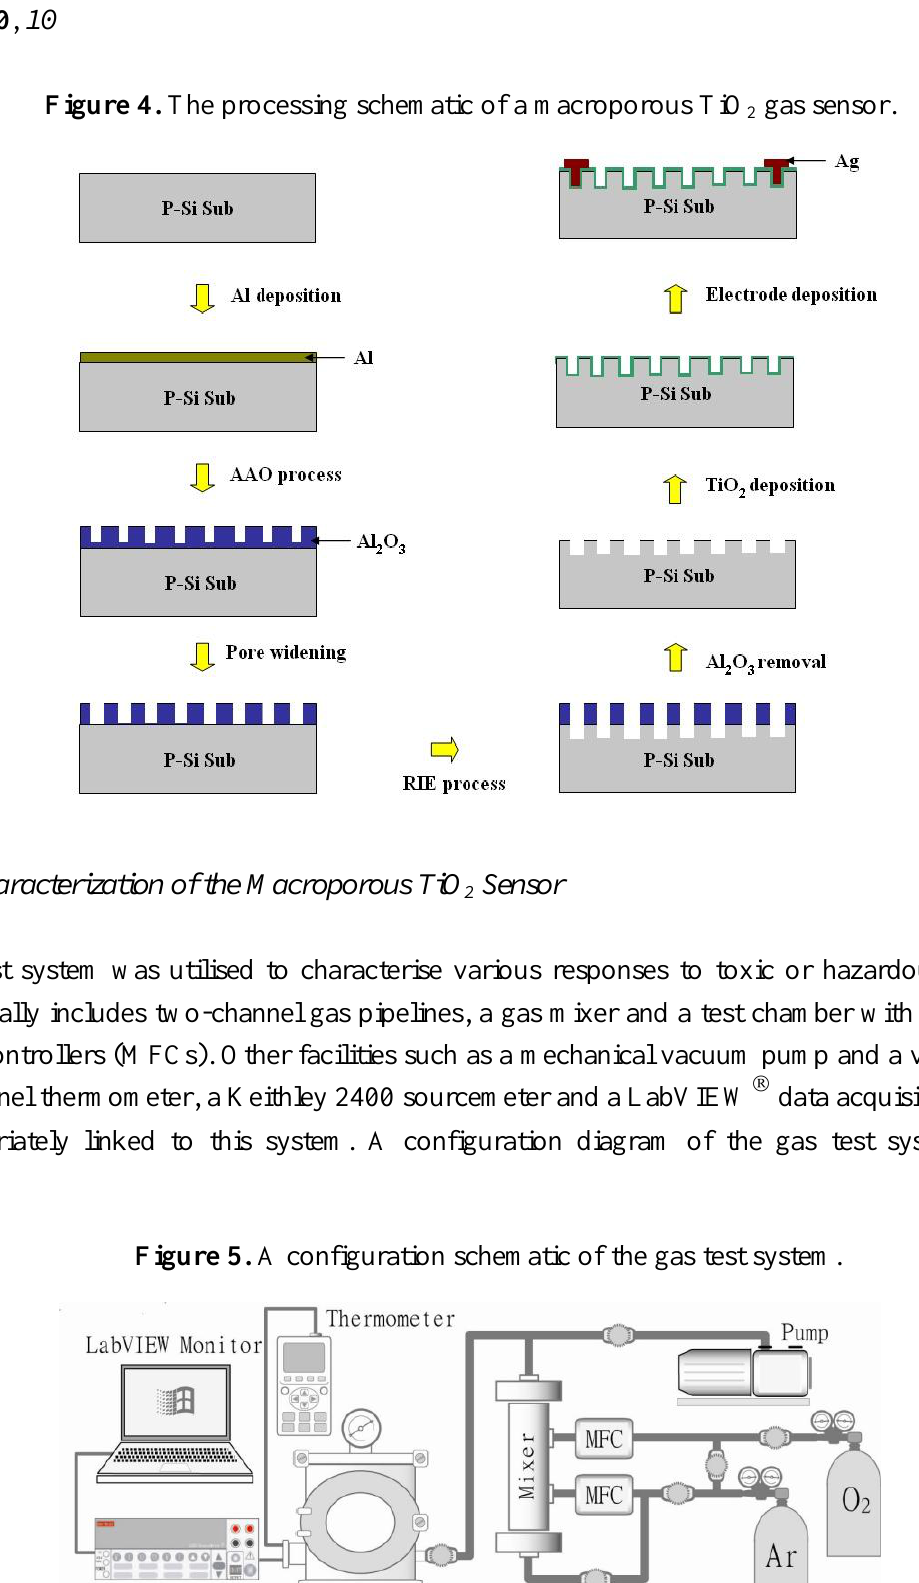
Figure 4. The processing schematic of a macroporous TiO